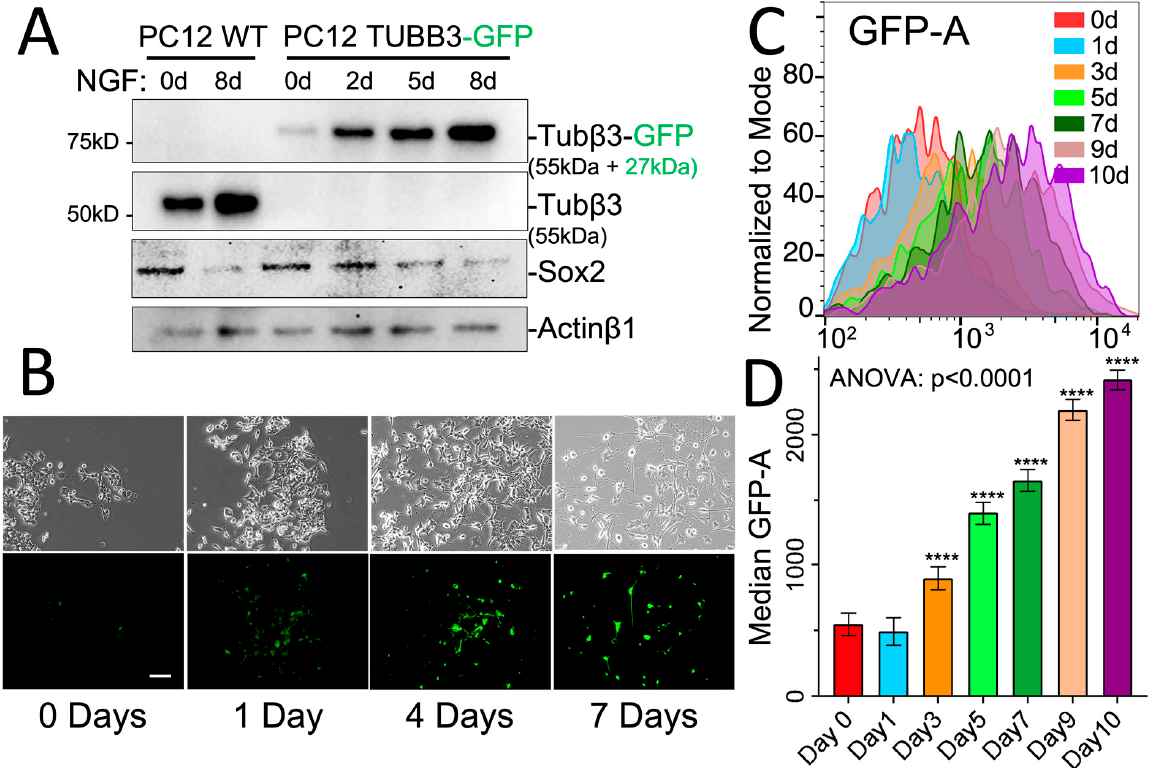
Figure 3. Analysis of intermediate states of neuronal differentiation using the GFP reporter. ( A ) Western blot analysis was performed on protein lysates extracted from a culture of PC12 cells treated over a time course of 2 to 8 days (Original Western blot, see Supplementary File S1). Results showed a progressive increase in GFP expression (Tub β 3-GFP: hybridization with GFP antibody), with a signal observed at around 82 kDa corresponding to the size of the combined GFP and β 3-tubulin proteins. Sox2, a marker of neuronal stem cells, was used to indicate neuronal differentiation occur- ring during the time course. Actin β 1 was used as a loading control. ( B ) The progressive induction of neuronal differentiation and GFP expression was further validated through conventional fluorescence microscopy observation, which revealed an incremental increase in fluorescence signal over time. ( C ) Flow cytometry was used to assess the sensitivity of our approach in a high-throughput setup. We accurately monitored the time response of the neuronal differentiation process in PC12 cell cultures that were stimulated with NGF (100 ng/mL) for 0 to 10 days, providing an in-depth visualization of the intermediate states of differentiation at a single cell level and in a large population of cells. ( D ) The results obtained from the fl ow cytometry analysis were quanti fi ed, and data are expressed as median signal +/ − coe ffi cient of variation (CV). Statistics: Ordinary one-way ANOVA and Tukey’s multiple comparison t-tests. **** p < 0.0001. Scale bar: 50 µm